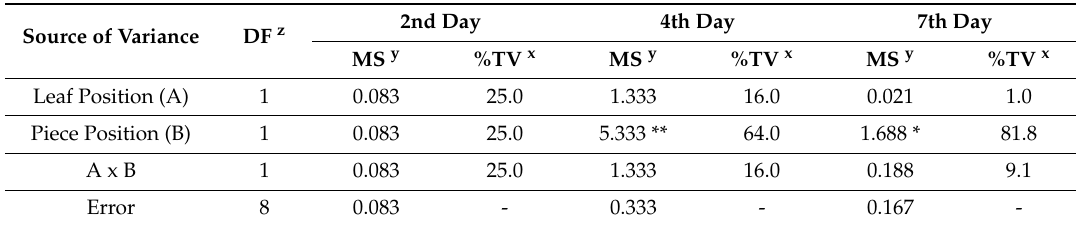
Figure 2. Browning of fresh-cut ‘d’America rossastra’ butterhead lettuce during storage at 10 °C, as affected by piece position on the leaf. Comparisons of the means were separately performed for each storage day. Columns with different letters are significantly different ( a < 0.05). Table 4. Analysis of variance for PAL activity of fresh-cut ‘d’America rossastra’ butterhead lettuce, during storage at 10 °C for 7 days.